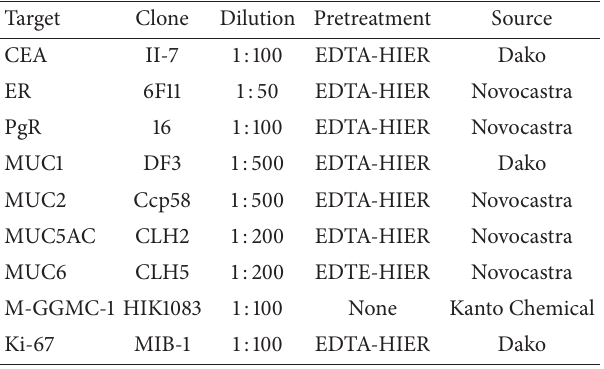
Table 1: Mouse monoclonal antibodies used in the present